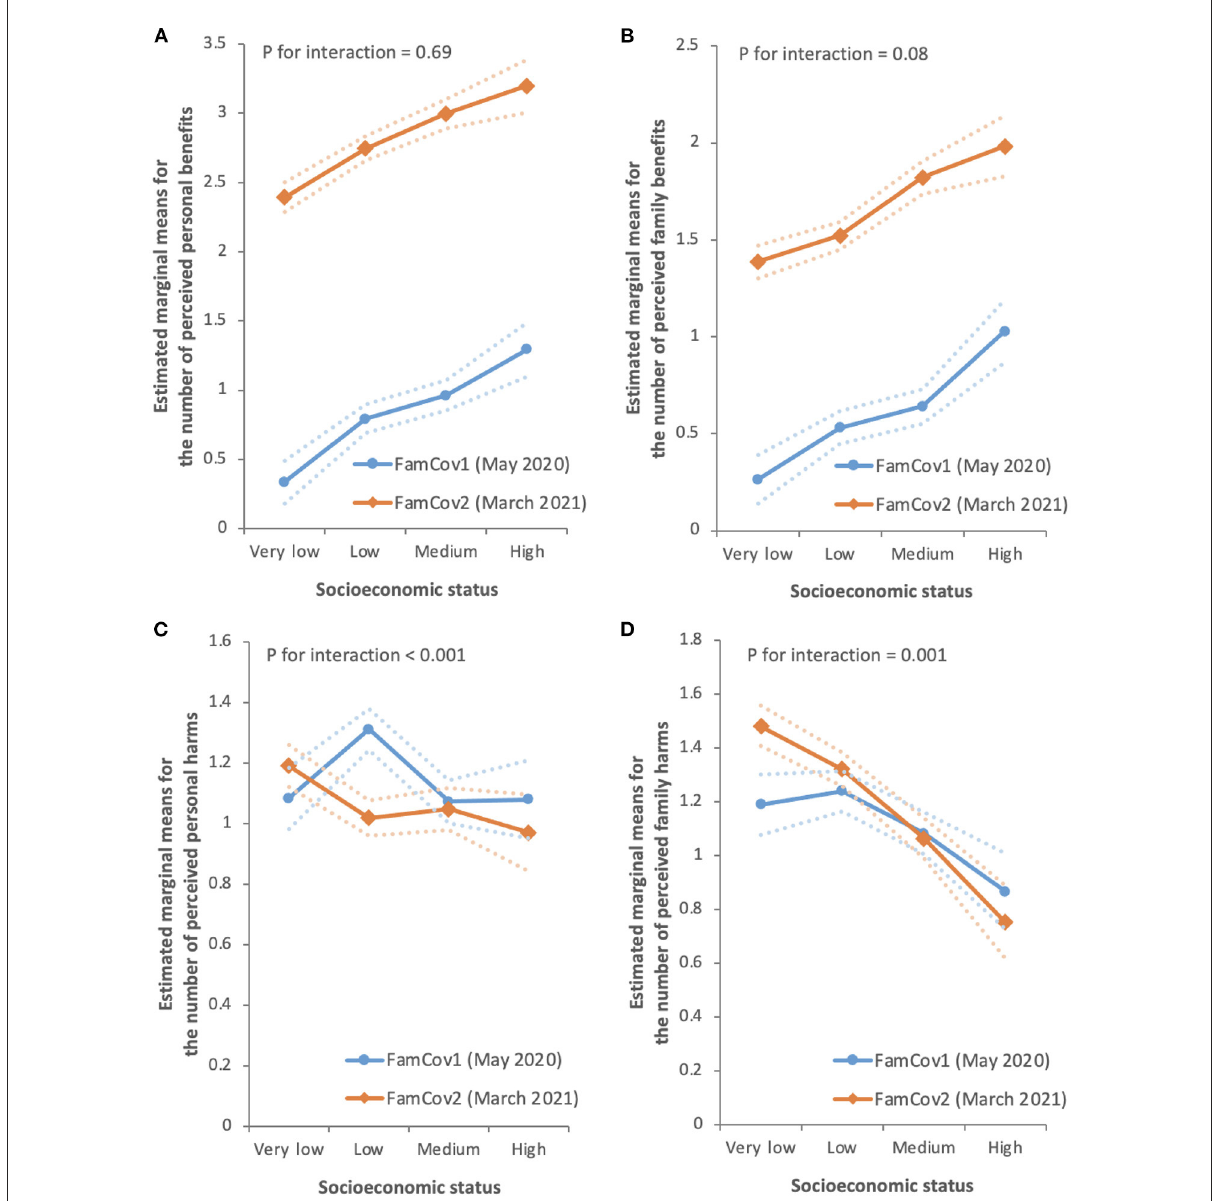
FIGURE2 Sex- and age-adjusted estimated marginal means for the number of perceived personal benefits (A) , family benefits (B) , personal harms (C) , and family harms (D) by socioeconomic status (SES) for each survey. The error bands indicate the upper and lower bounds of the 95% confidence intervals. Socioeconomic status was defined by a composite score of education, household monthly income per person, and housing, analyzed as very low (0), low (1), medium (2) and high (3). Weighting was applied based on the distribution of sex, age, and education in the 2020 Hong Kong